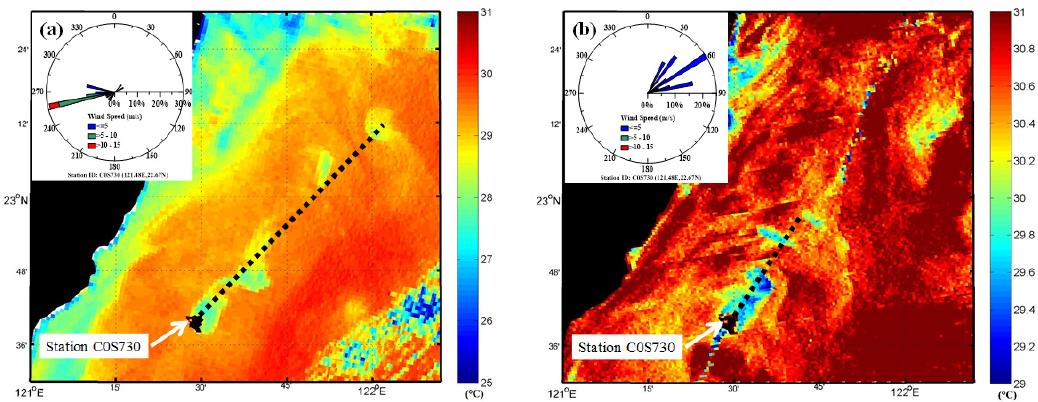
Figure 10. VIIRS-NPP SST images under ( a ) the SW wind condition at 18:00 UTC on 8 August 2017 and ( b ) the NE wind condition at 05:00 UTC on 11 September 2017.